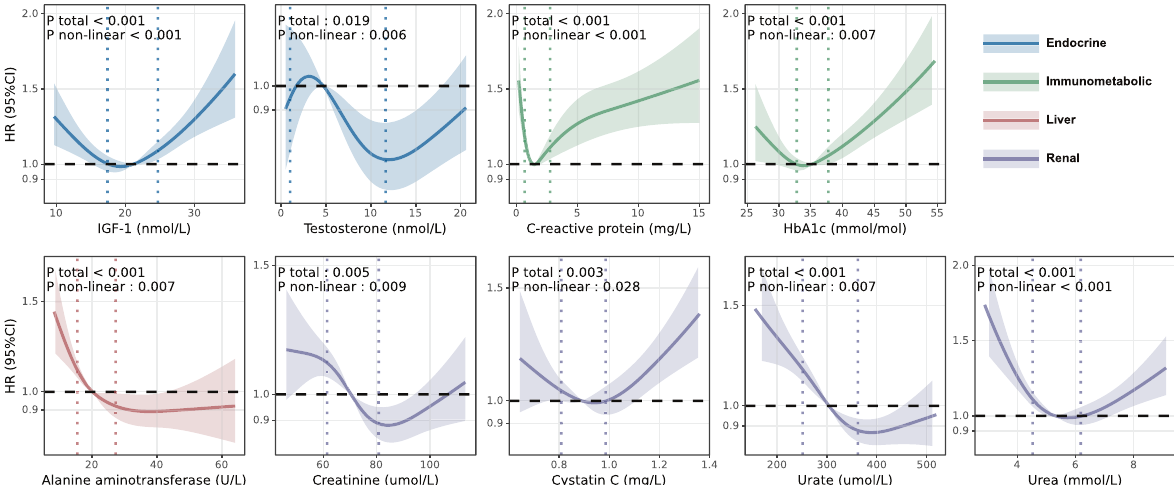
Fig. 3 Nonlinear associations between serum laboratory tests and risk of incident dementia. Restricted cubic spline models fi tted for Cox proportional hazards models with four knots for 9 signi fi cant nonlinear associations from the main analysis (The remaining 21 non-signi fi cant associations are shown in Supplementary Fig. 2) Two dashed vertical lines represent 25% and 75% values of each exposure. Results were adjusted for demographic, temporal, socioeconomic, lifestyle and medication variables. The blue, green, red and purple indicates each of serum laboratory tests fi tting into “ endocrine ” , “ immunometabolic ” , “ liver ” and “ renal ” category. CI con fi dence interval, HR hazard